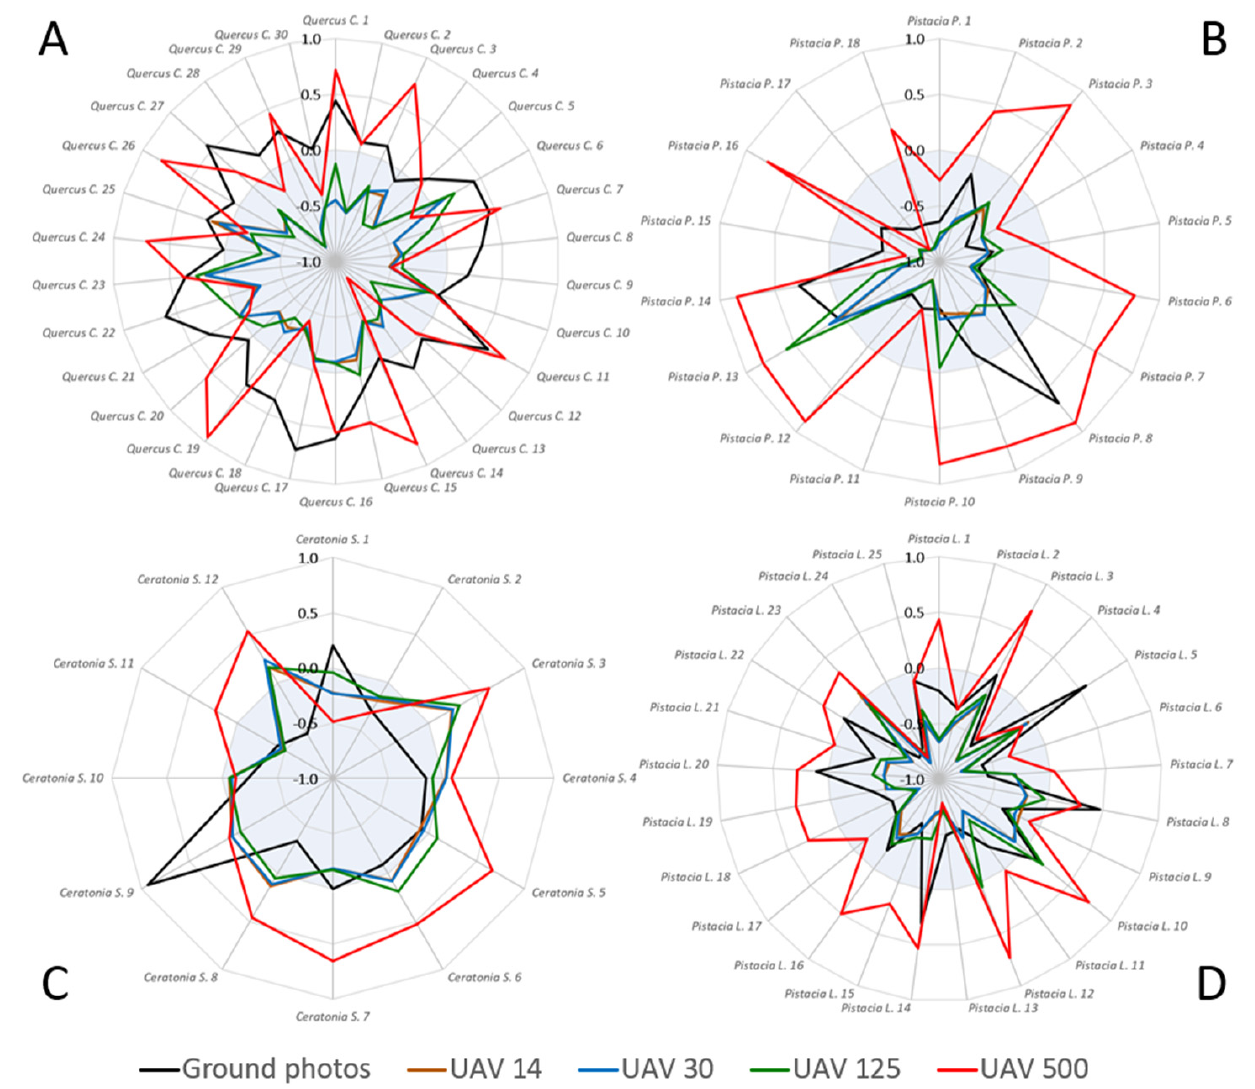
Figure 12. Correlations between ExG values of individual plants extracted from the ground photos and UAV images (11 dates) of the following species: Palestine Oak ( A ), Terebinth ( B ), Carob ( C ), Mastic tree ( D ), and mean ExG values of Herbaceous vegetation (all ROIs per date), detected by the same sensor (ground photos and UAV), at the individual plant level. Negative correlations range in the bluish background.